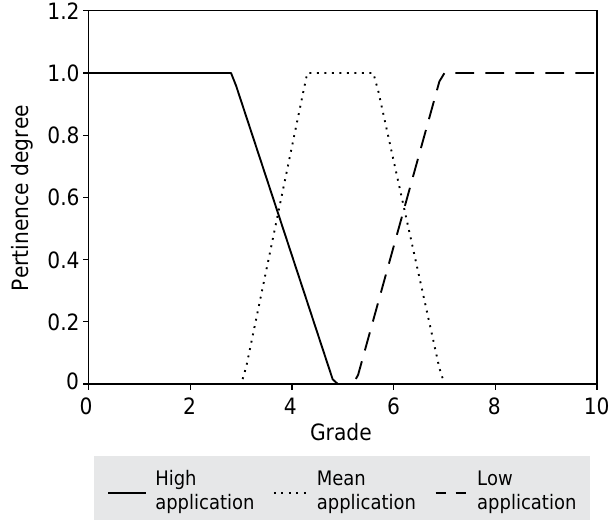
Figure 1. Fuzzy sets for the variable of output need for input